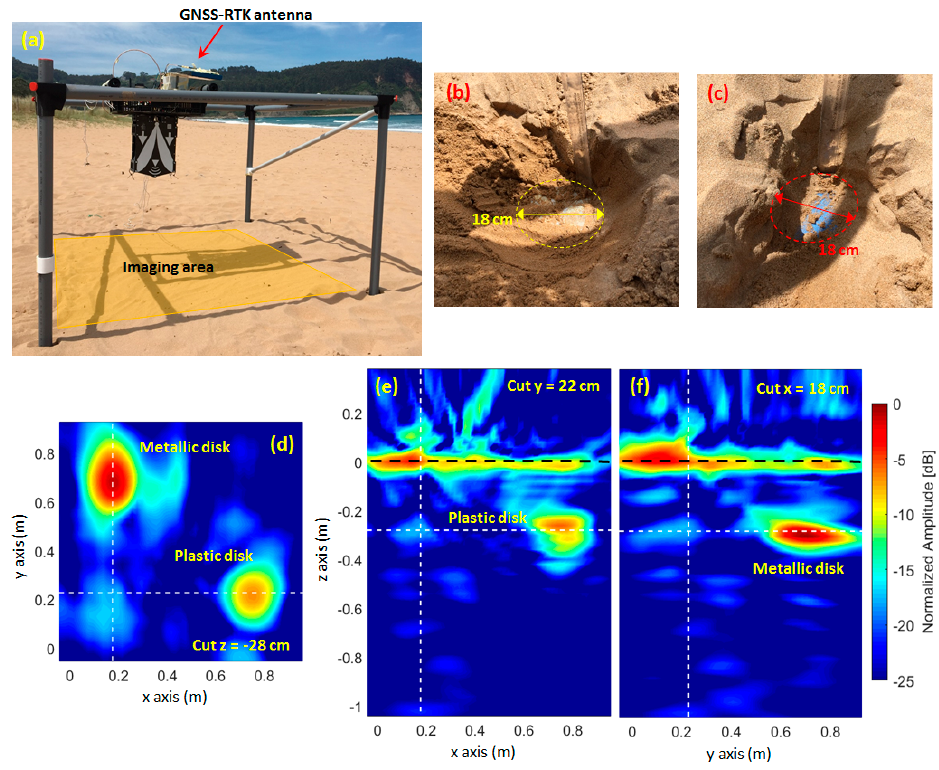
Figure 12. Measurements in sandy soil. Picture of the portable measurement setup in the selected scenario ( a ). Picture of the 18 cm diameter metallic disk, buried 18–20 cm deep ( b ). Picture of the 18 cm diameter plastic disk, buried 16–18 cm deep ( c ). Synthetic Aperture Radar (SAR) images, normalized reflectivity: cut z = -28 cm ( d ), cut y = 22 cm ( e ), and cut x = 18 cm ( f ).